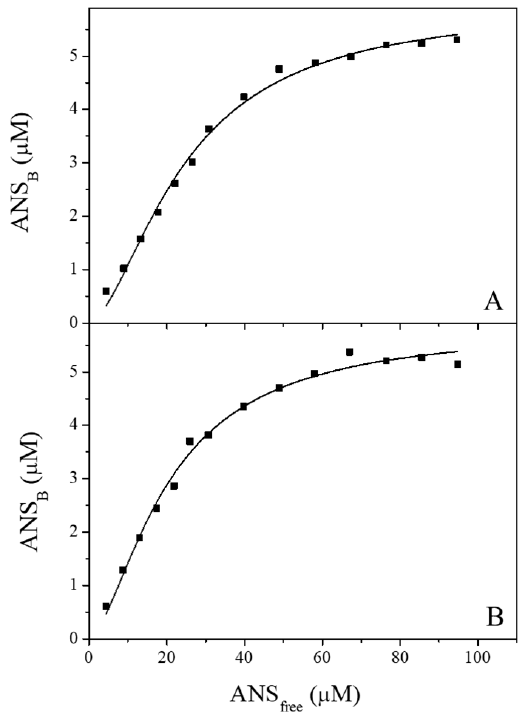
Figure 4. Concentration of ANS bound ([ANS] B ) to POPE:POPG (3:1, mol/mol) liposomes as a func- tion of the free ANS concentration ([ANS] free ). ( A ) Blank liposomes; ( B ) liposomes incubated with 5 nM of G1OLO-L 2 OL 2 .